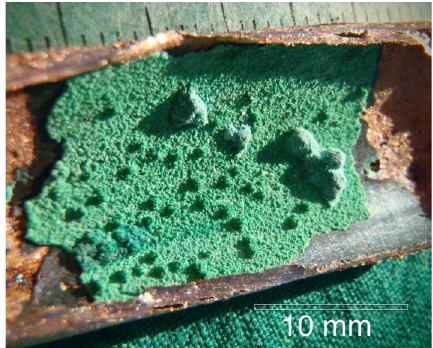
Figure 2. The malachite mounds found on the interior of the copper tubing.